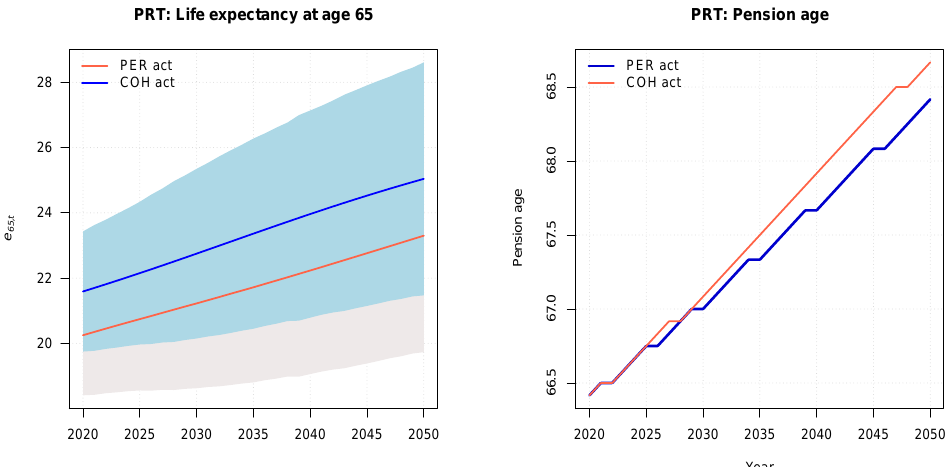
Figure 8. PRT: BME forecast of unisex period and cohort life expectancy and pension age along with 95% prediction